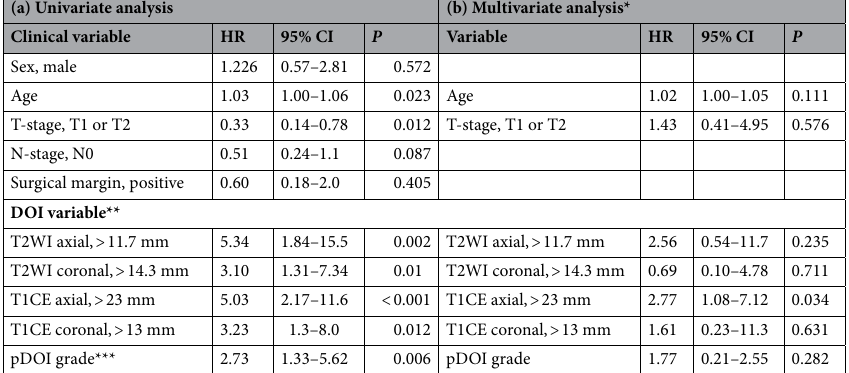
Table 4. Cox proportional hazards analysis of overall survival. HR hazards ratio, CI confidence interval, T2WI T2-weighted image, T1CE T1-weighted contrast enhanced image, pDOI pathologic depth of invasion. *Variables with P < 0.05 from univariate analysis were chosen. **Cutoff values were determined by optimal stratification based on log-rank statistics. ***Grade 1 (pDOI < 5 mm); grade 2 (pDOI 5–10 mm); grade 3 (pDOI ≥ 10